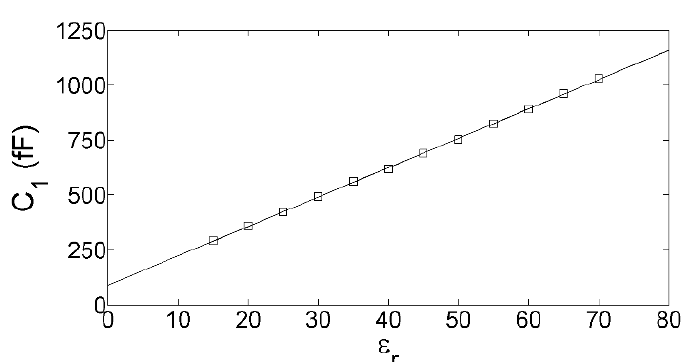
Figure 6. Behavior of C 1 versus ε r with the approximating straight line for the lossless MUTs placed on top of the sensing area of the IDC sensor.